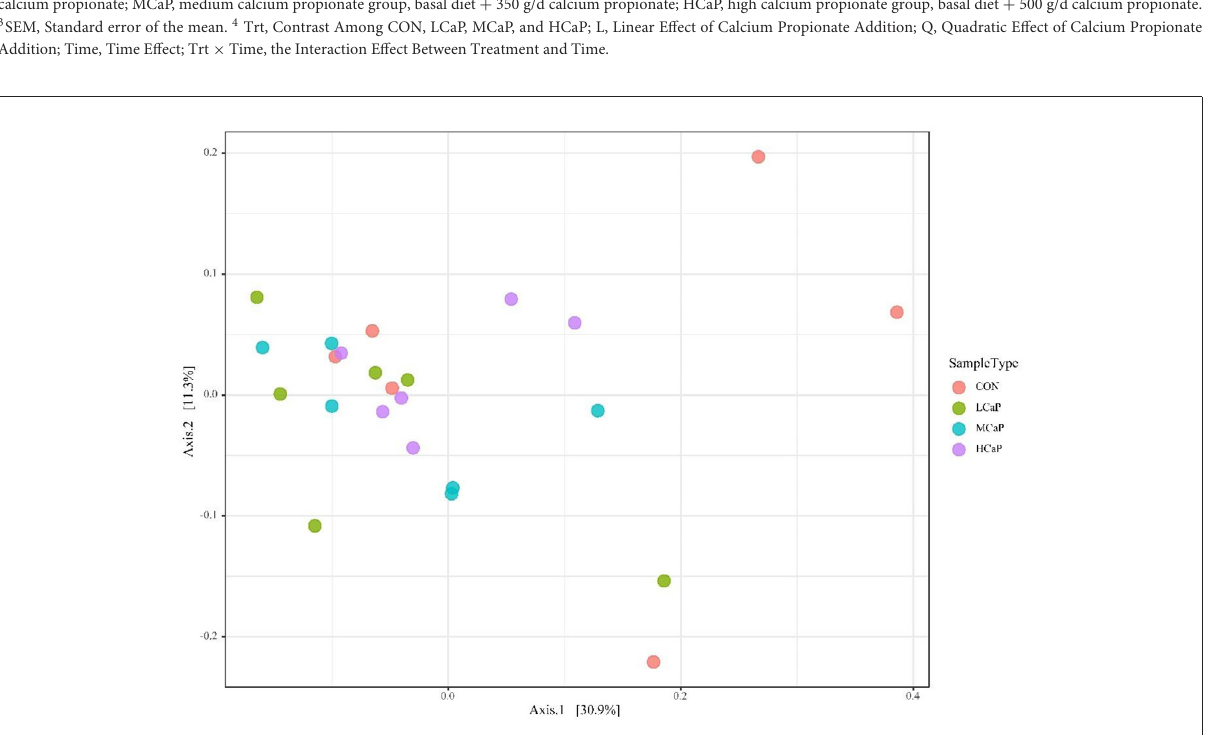
FIGURE1 Principal coordinates analysis (PCoA) of beta diversity using Bray-Curtis distances in the fecal bacterial communities. Each point of the PCoA represents a sample among the different levels of calcium propionate treatments. The greater similarity in the bacterial communities of the samples, the lower distance of the points. CON, control group; LCaP, low calcium propionate group, basal diet + 200 g/d calcium propionate; MCaP, medium calcium propionate group, basal diet + 350 g/d calcium propionate; HCaP, high calcium propionate group, basal diet + 500 g/d calcium